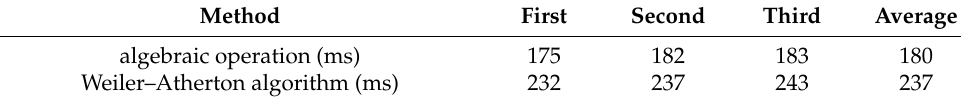
Figure 18. Experiments of overlay: layer ( a ) and layer ( b ) are the layers to be overlaid that have only one area object; layer ( c ) is the result of the overlay. The pink and green areas are the original areas. The purple area is the overlaid area. Table 2. Comparing a study of the two algorithms for the layer with a single area.